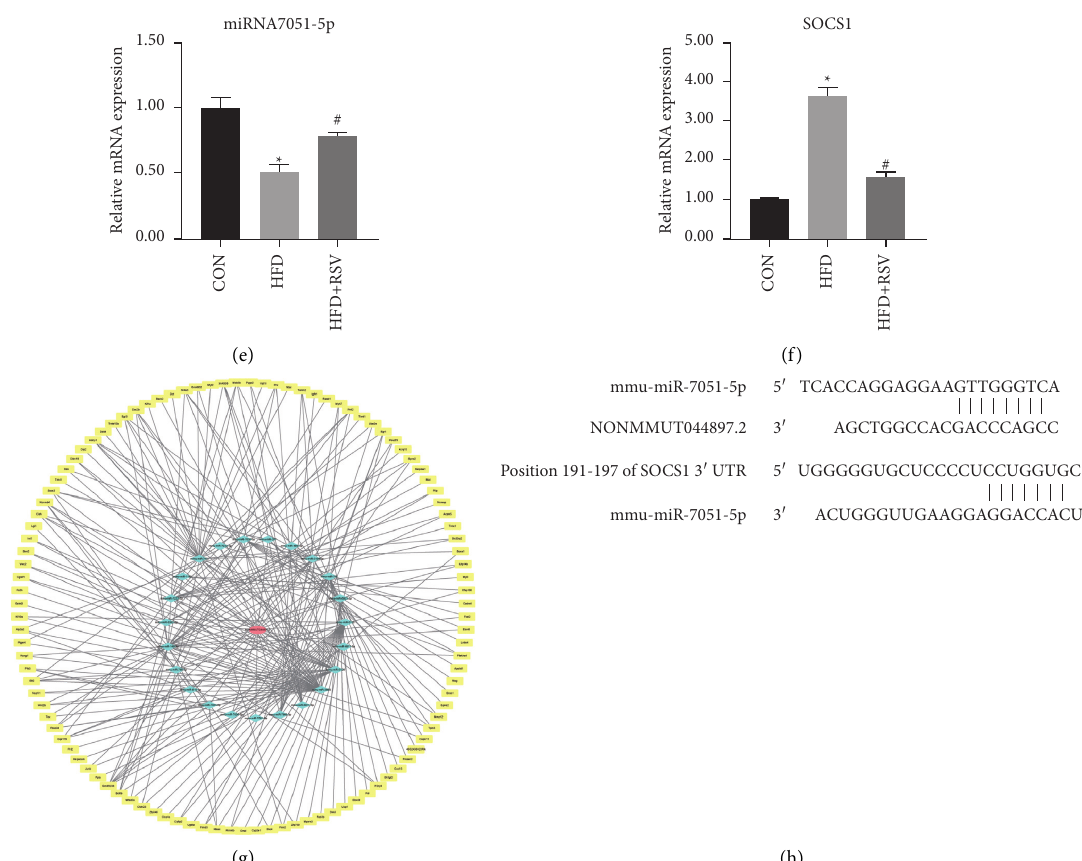
Figure 4: Validation of lncRNAs by RT-qPCR in vivo . Expression of NONMMUT005295.2 (a), NONMMUT044897.2 (b), NON- MMUT128951.1 (c), NONMMUT145909.1 (d), miRNA-7051-5p mRNA (e), and SOCS1 mRNA (f) in different groups. (g) The NON- MMUT044897.2 lncRNA-miRNA-mRNA network. (h) The positions of miR-7051-5p binding sites on NONMMUT044897.2 and the positions of miR-7051-5p binding sites on SOCS1. Data are expressed as the mean ± SD ( n � 6). ∗ P < 0 . 05 versus CON; # P < 0 . 05 versus